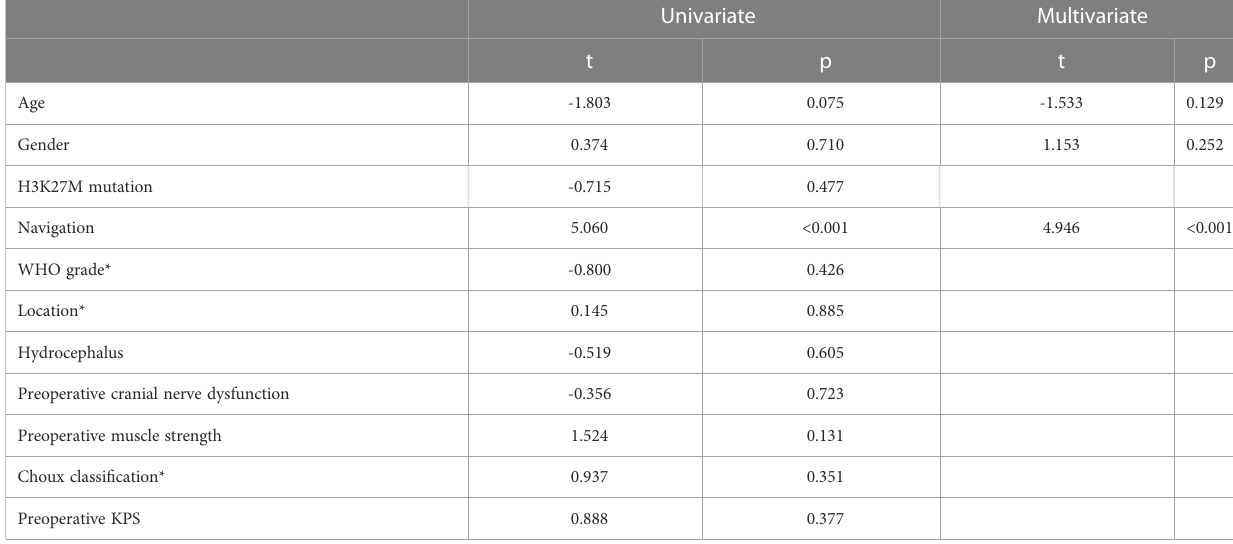
TABLE 4 Univariate and multivariate leaner regression showing the usage of NN is an independent factor for the extent of resection in the non-DIPG patients.